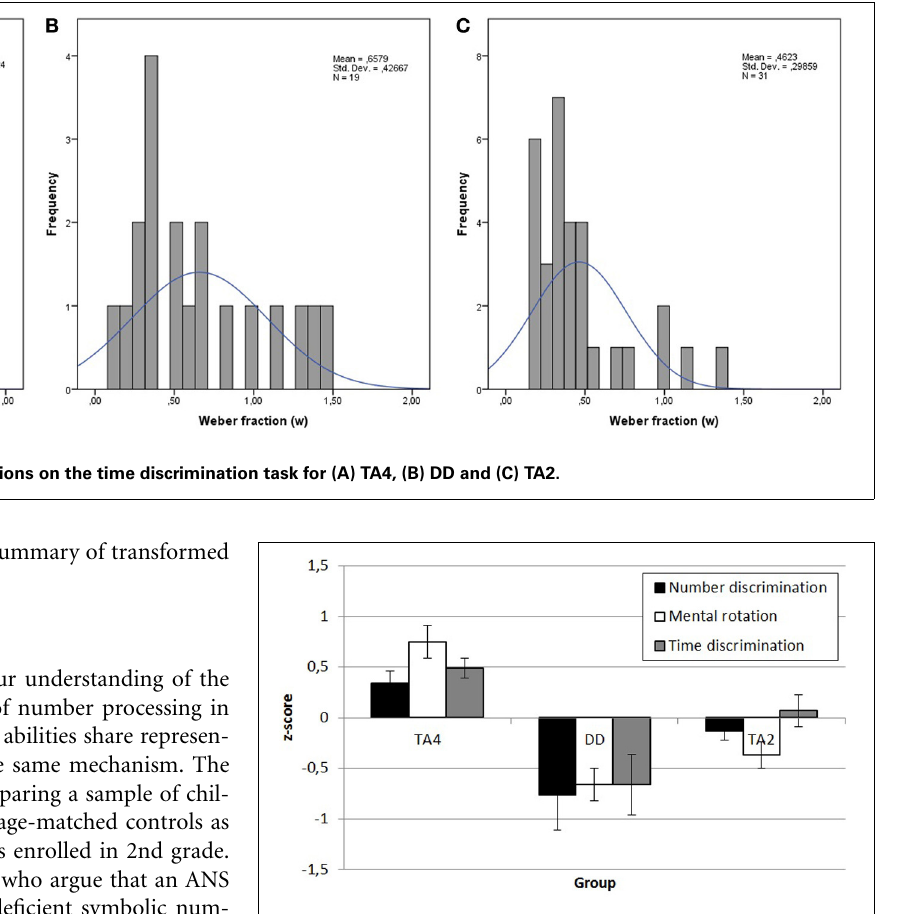
FIGURE 3 | Overview of z-transformed magnitude processing scores for each